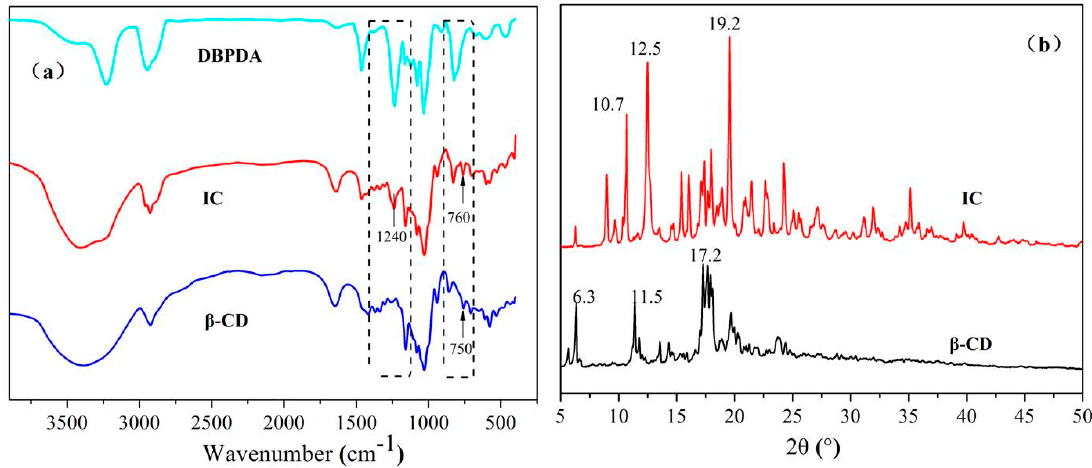
Figure 1. ( a ) FTIR spectra of DBPDA, IC and β -CD; and ( b ) WAXD spectra of IC and β -CD.